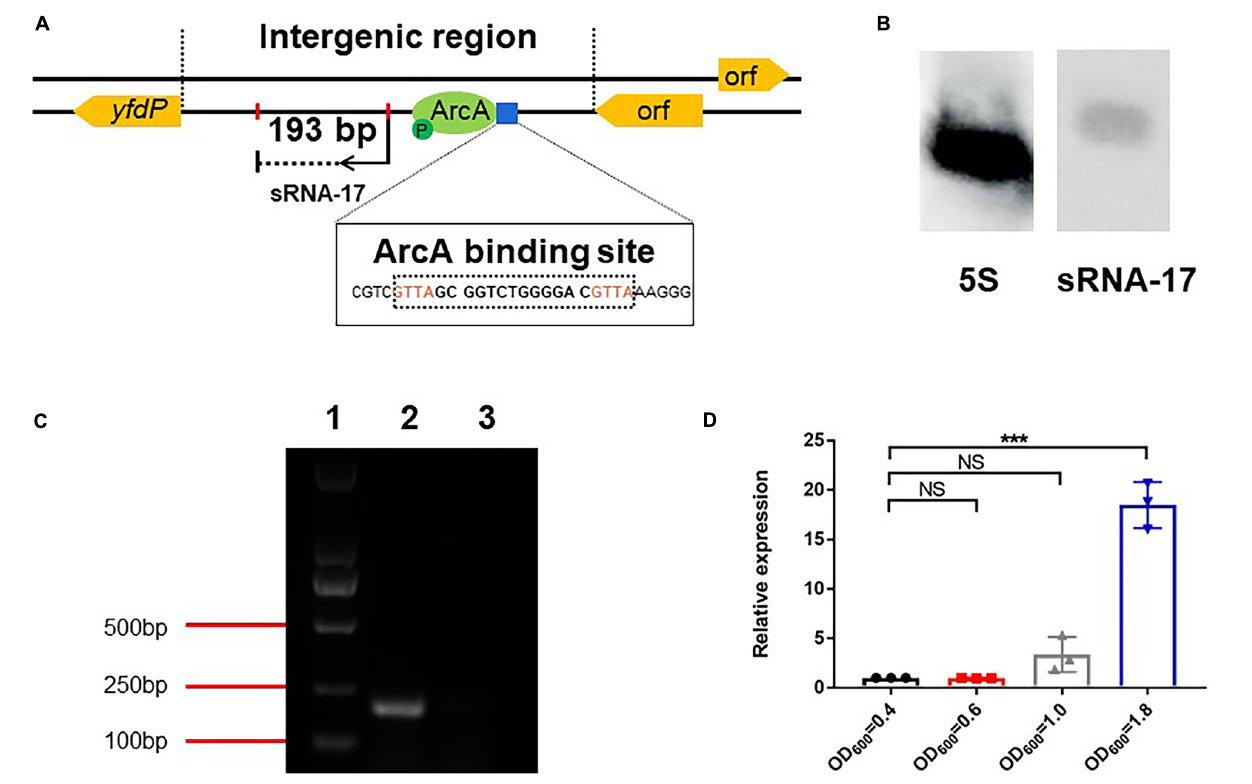
FIGURE 2 | Expression analysis of sRNA-17. (A) Identification of sRNA-17 and ArcA-binding site in Escherichia coli K1 genome. (B) Northern blots were probed for sRNA-17 to further verify that sRNA-17 was a non-coding RNA. The 5S rRNA served as the loading control. (C) Electrophoresis of amplified sRNA-17 on an agarose gel. The primers used for amplification of sRNA-17 were designed based on rapid amplification of complementary DNA ends (RACE) sequencing result. Lane 1, marker D2000; lane 2, wild-type strain; lane 3, (cid:49) sRNA-17 strain. (D) Expression of sRNA-17 at different growth phases. Fold change in the RNA levels of sRNA-17 in the Rs218 strain when growth reached OD 600 of 0.4, 0.6, 1.0, and 1.8, respectively. *** P < 0.001; NS, no significance, P >